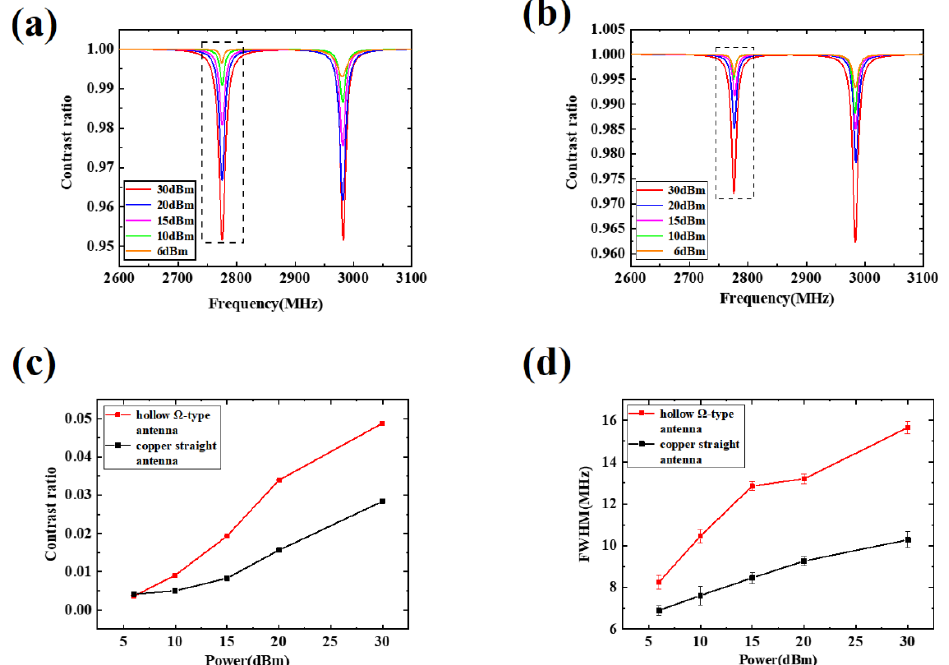
Figure 4. ( a ) ODMR of hollow Ω -type antenna; ( b ) ODMR of the straight copper antenna; ( c ) Contrast value of two antennas under different power; ( d ) Comparison of FWHM value of two antennas under different power.